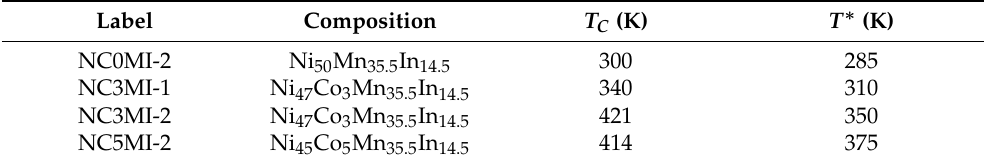
Table 2. The Curie temperature determined from temperature dependency of EMR integral intensity for Ni 50 − x Co x Mn 35.5 In 14.5 and T ∗ temperature. The T C values were taken from the literature